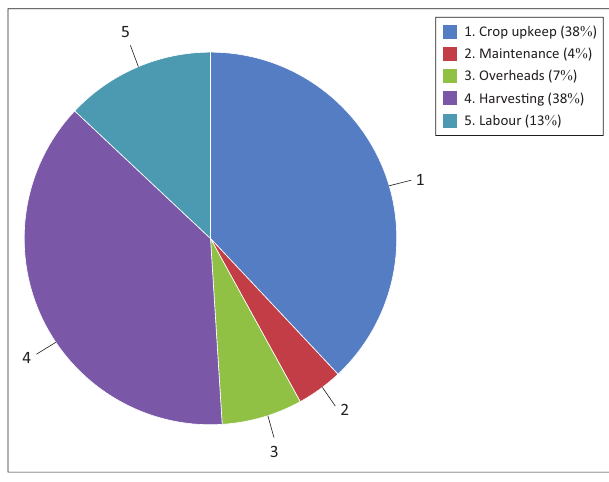
FIGURE 3: Farm operational cost